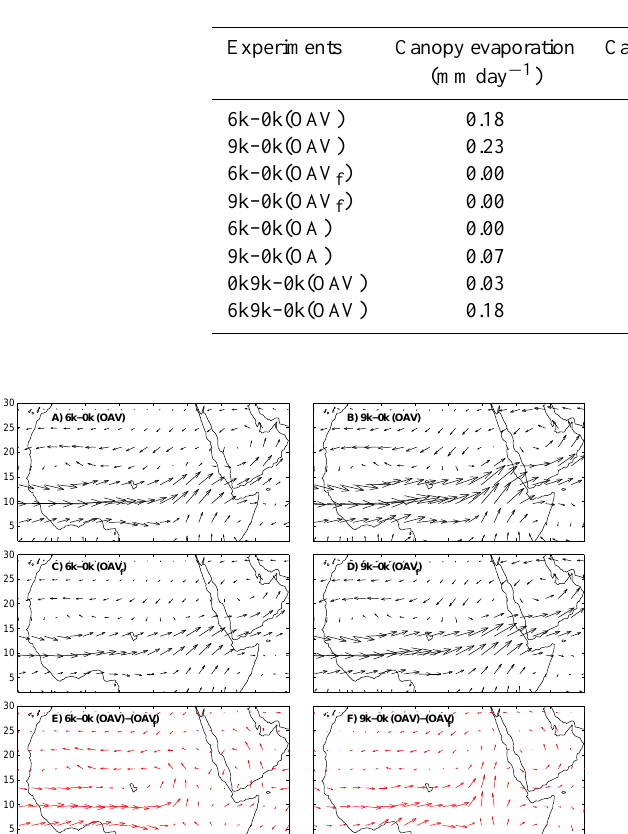
Table 3. Changes of summer (JJAS) canopy evaporation, canopy transpiration, and ground evaporation in the various early and mid-Holocene experiments over the region 10–25 ◦ N, 20 ◦ W–30 ◦ E.